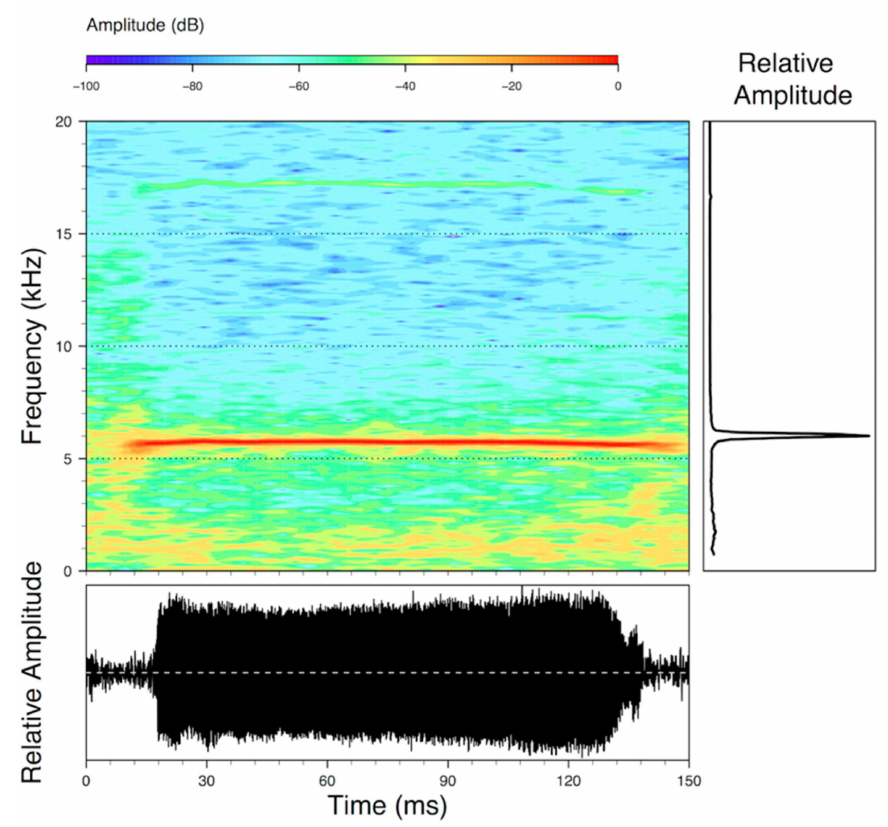
Figure 119. Call of Hyalinobatrachium pellucidum recorded at R í o Azuela, 1740 m, Napo province, Ecuador, recorded by Roy McDiarmid (USNM